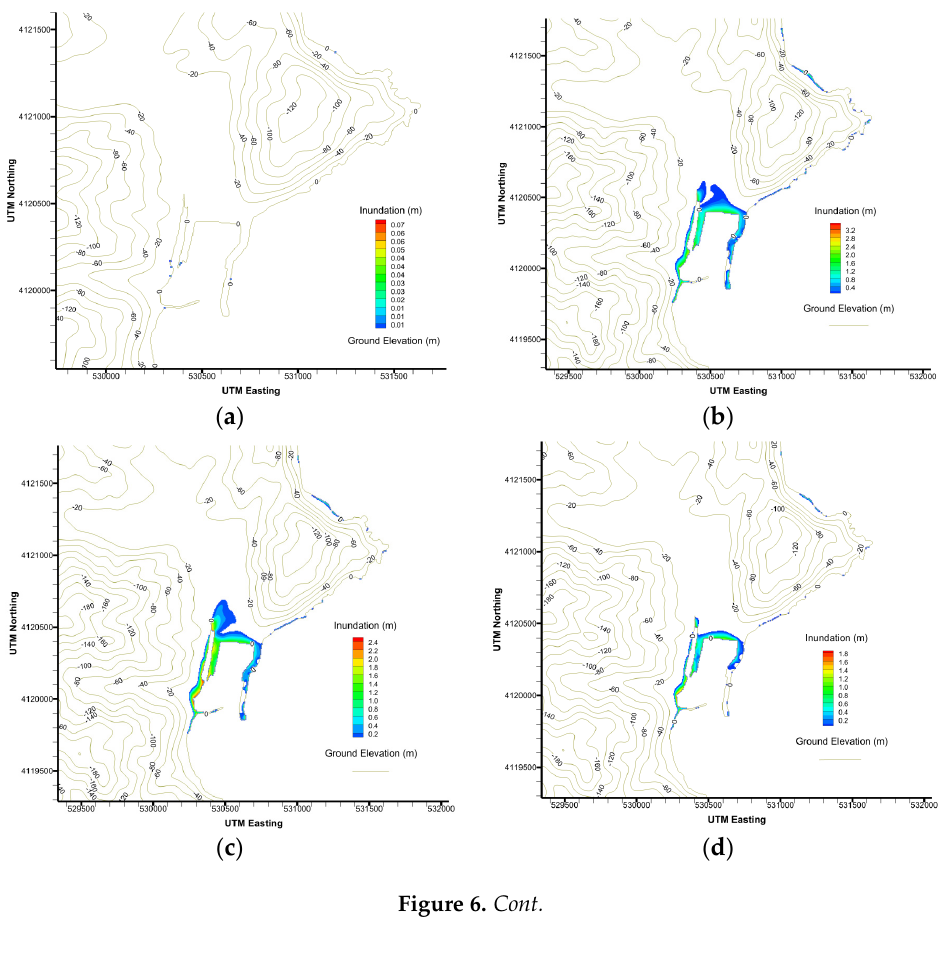
Figure 6. Cont. Figure 6.